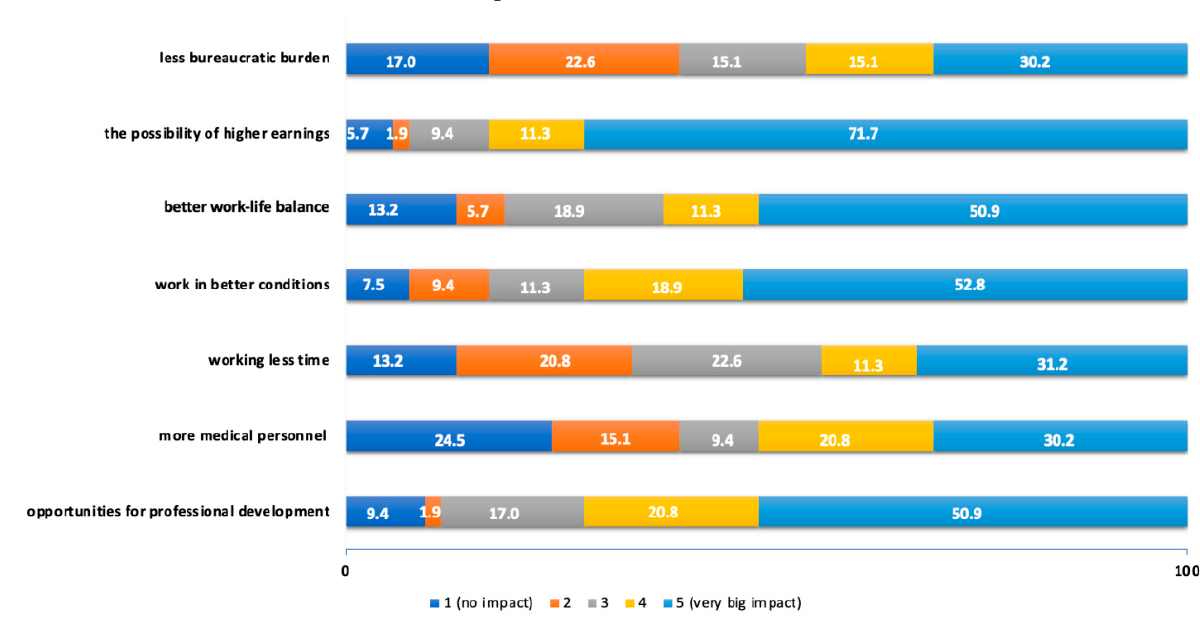
Figure 2. Assessment of the influence of pull factors according to students of physiotherapy.